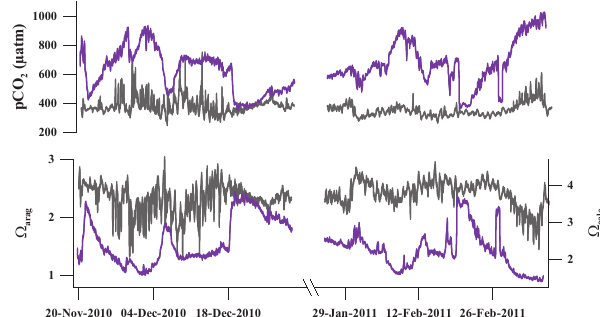
Fig. 10. Estimates of p CO 2 and saturation state of aragonite and calcite ( (cid:127) arag and (cid:127) calc ) at 7m (grey) and 17m (purple) water depth at mooring A during two separate deployments. The width of the line at each point represents the range estimated for p CO 2 or (cid:127) as calculated from pH, temperature, and salinity measured by the SeapHOx sensor and a TA range of 2225–2260µmolkg − 1